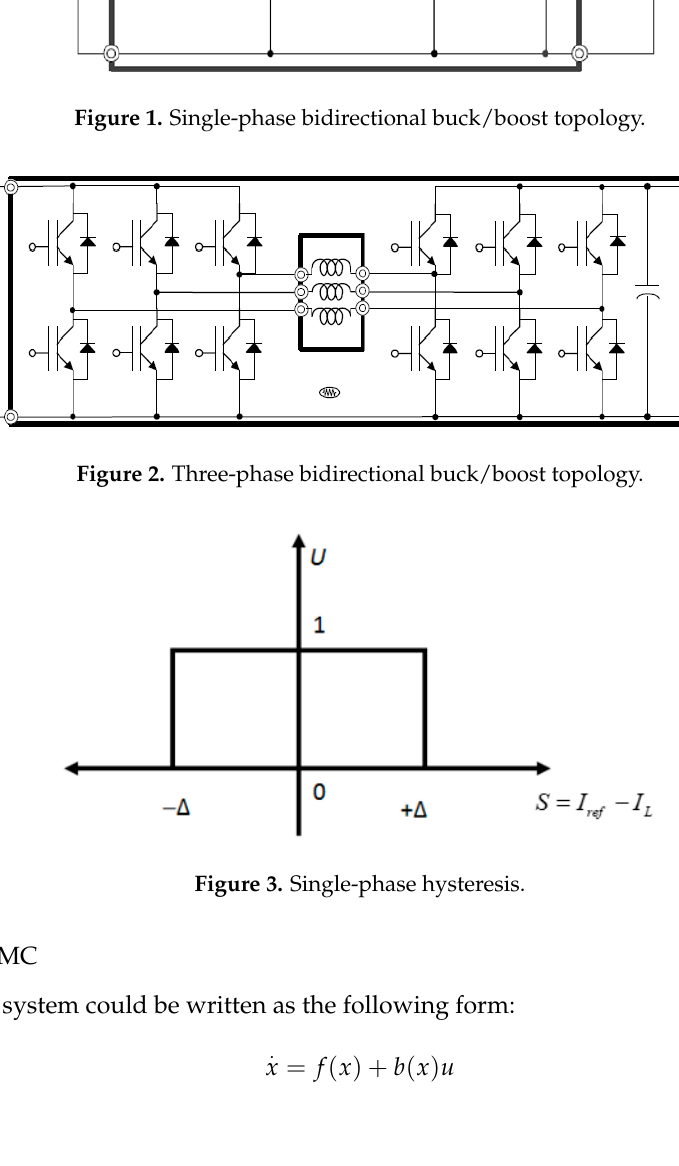
Figure 3. Single-phase hysteresis.